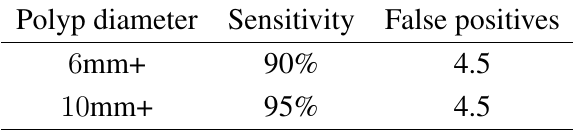
Table 3. Evaluation of our CAD on 202 patients at the specified operating point.